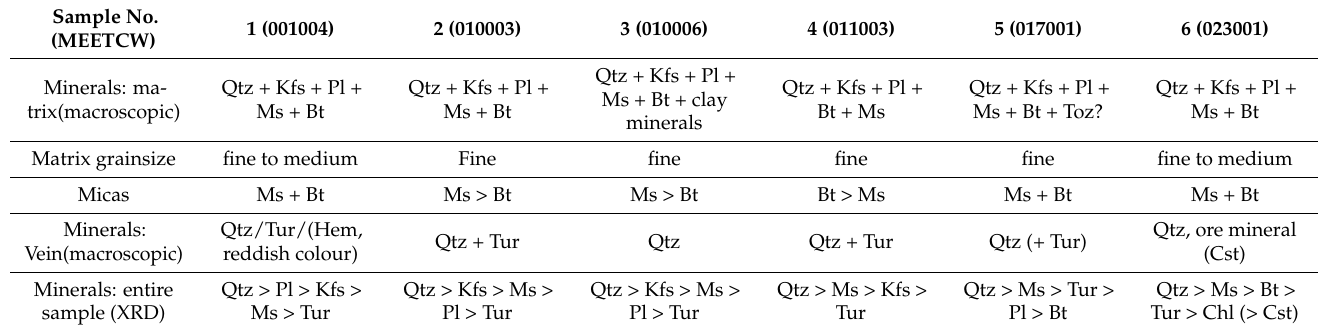
Table 3. Composition of the six analysed samples. Mineral abbreviations according to Kretz